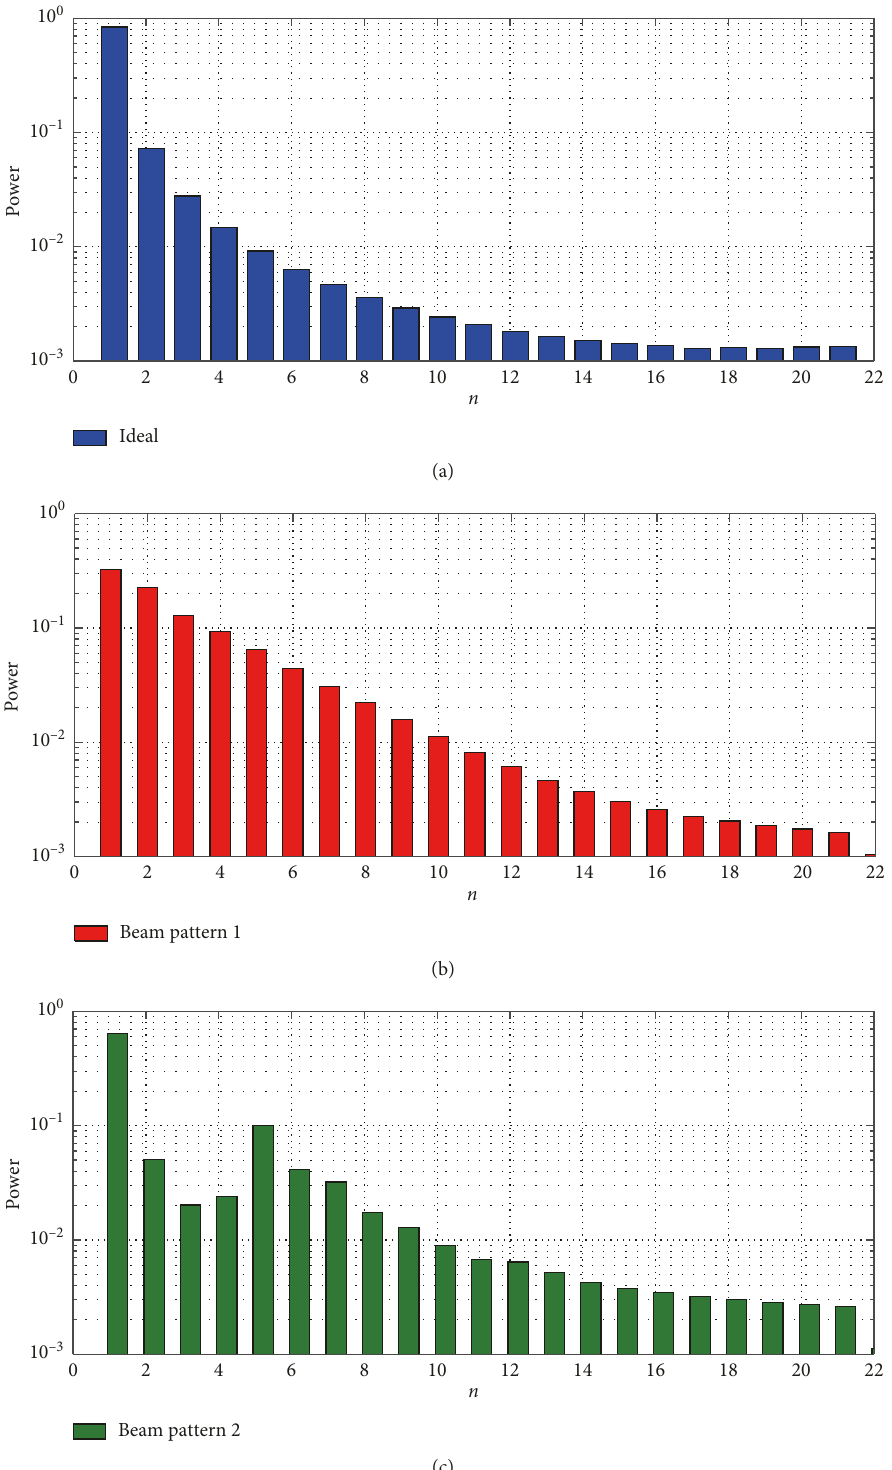
Figure 2: Power in different diffraction radius rings with different Zernike combinations: (a) no phase aberrations, (b) 1 st to 14 th order Zernike phase, and (c) 91 st to 104 th order Zernike